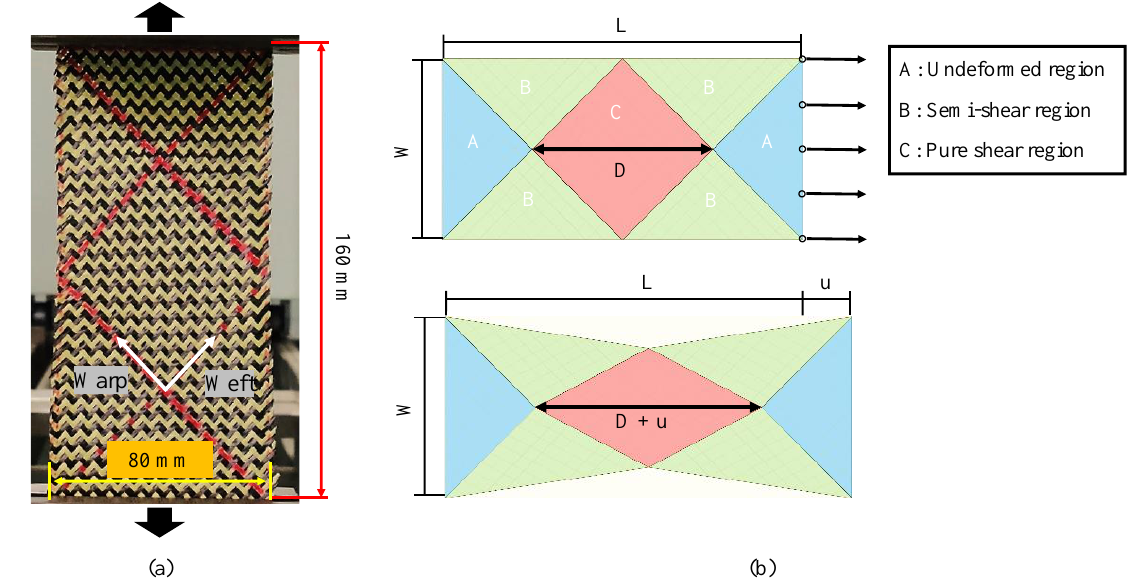
Figure 3. Tested specimen in the bias-extension test: ( a ) tested specimen; ( b ) illustration of the specimen before and after deformation.